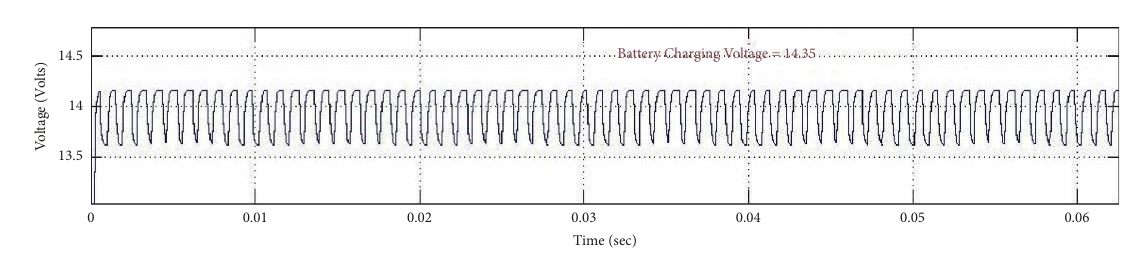
Figure 10: Battery charging voltage response.